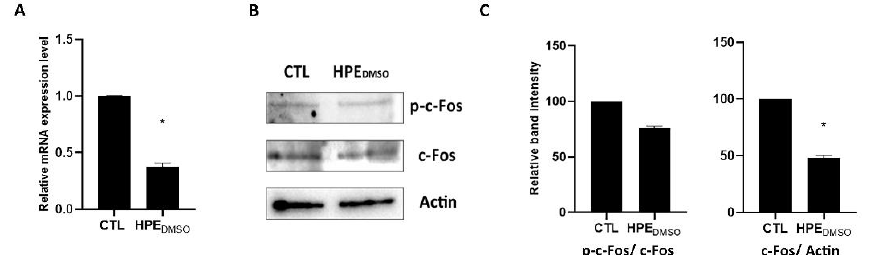
Figure 5. Effects of HPE DMSO on c-Fos production and activation. ( A ) Cells were treated with 0.1 mg/mL HPE DMSO for 24 h and then the mRNA was extracted and analyzed by RT-PCR. c-Fos mRNA level was reported as relative mRNA expression level with respect to 18S mRNA (2 − ∆∆ Ct method); ( B ) Cells were treated as described in A and then proteins were extracted and analyzed by western blot using anti-c-Fos/ p -c-Fos and anti-actin antibodies; ( C ) Densitometric analysis of bands obtained in western blot experiment, performed by ImageJ. Results are expressed as mean ± SEM of data obtained by three independent experiments. * p < 0.05 vs.